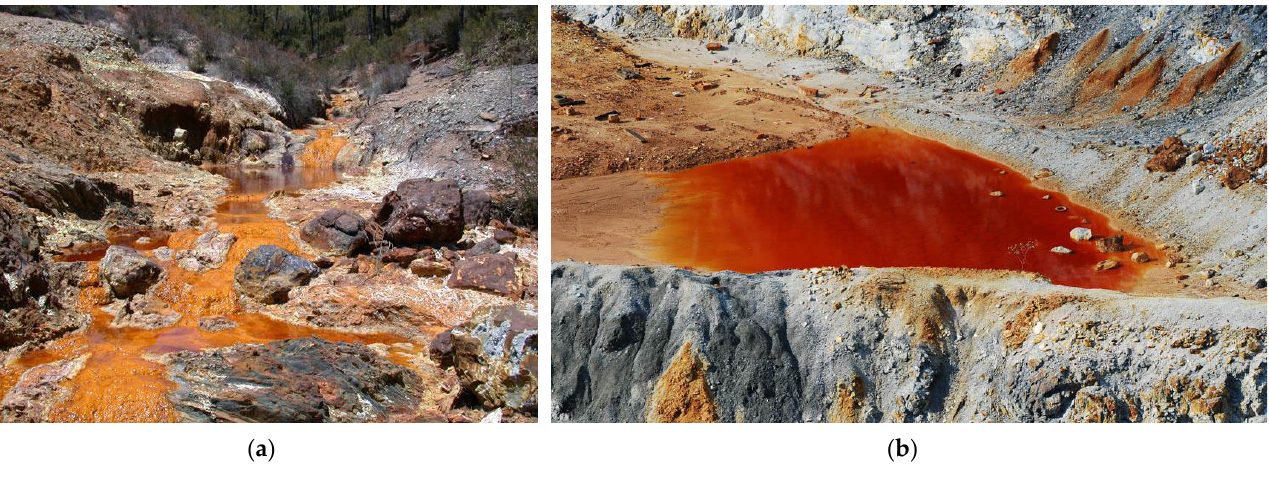
Figure 2. ( a ) Rio Tinto, a river in South Spain, affected by mine drainage; ( b ) Acid Mine Drainage in Central Sweden as seen by Copernicus Sentinel satellites.